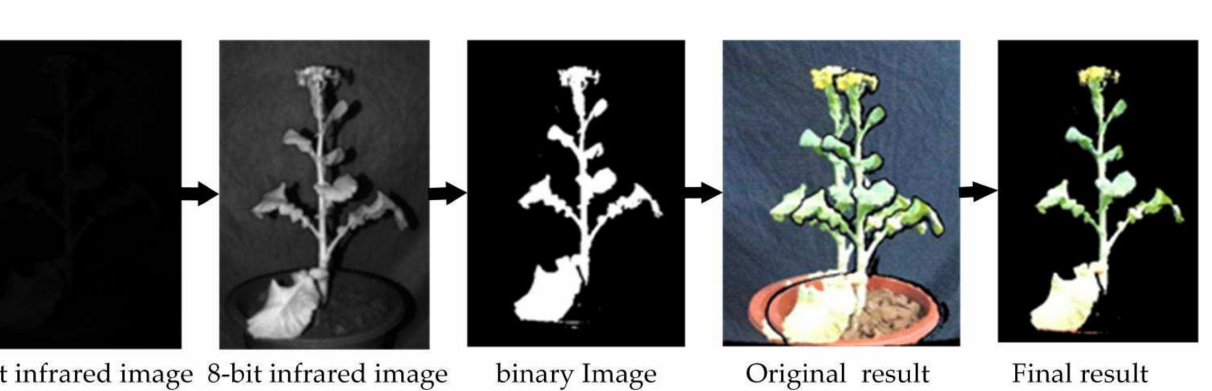
Figure 3. RGB-D images